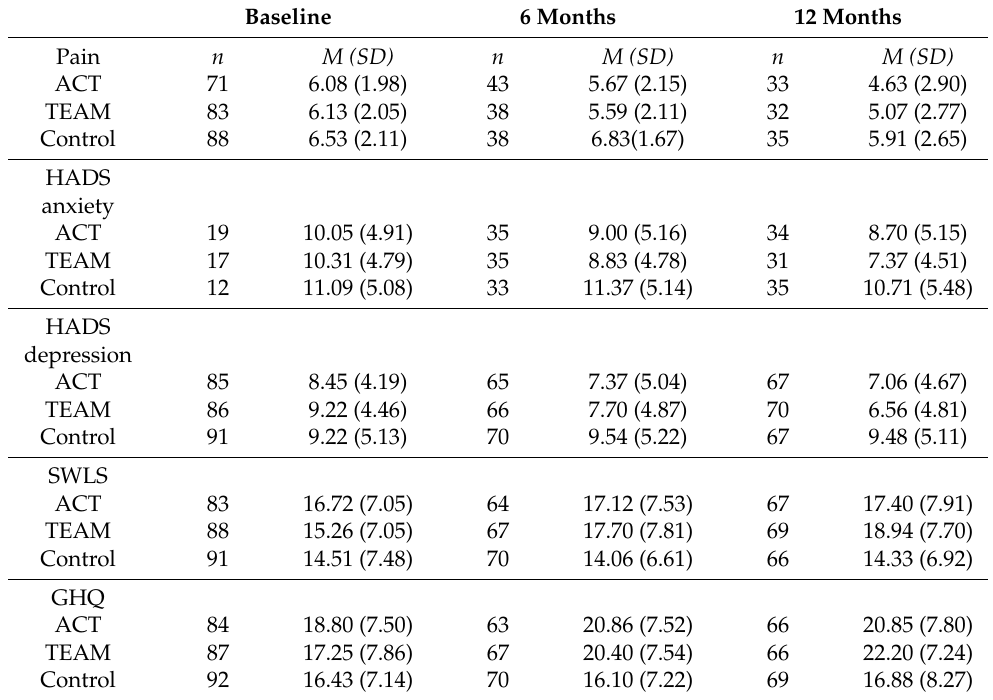
Table 2. Number of respondents, means, and standard deviations for the original data at baseline, 6 and 12 months for the outcome measures.